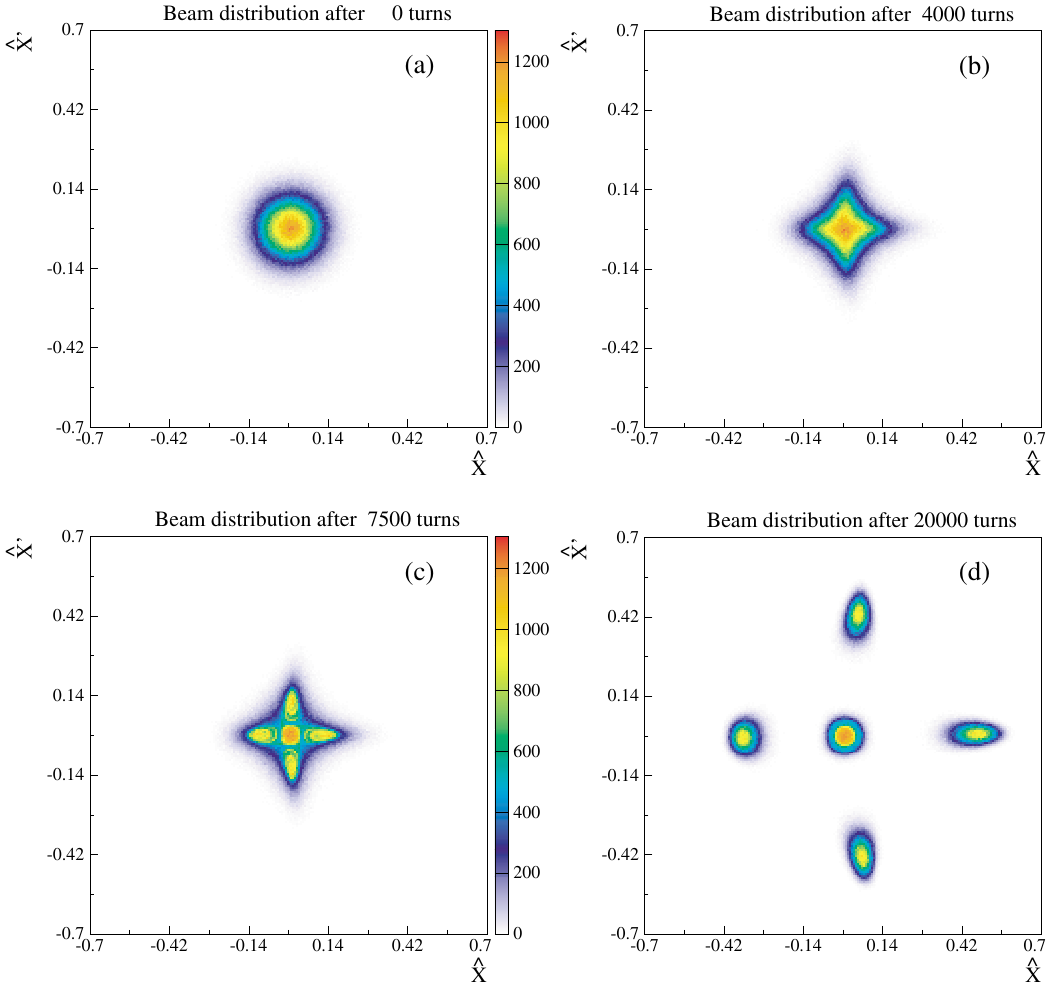
FIG. 6. (Color) Beam distribution during the trapping process with four islands ( 8 : 1 (cid:9) 10 5 initial conditions). The initial distribution is a Gaussian centered on zero, with standard deviation (cid:21) (cid:1) 0 : 073 , (cid:14) (cid:1) (cid:6) 1 : 5